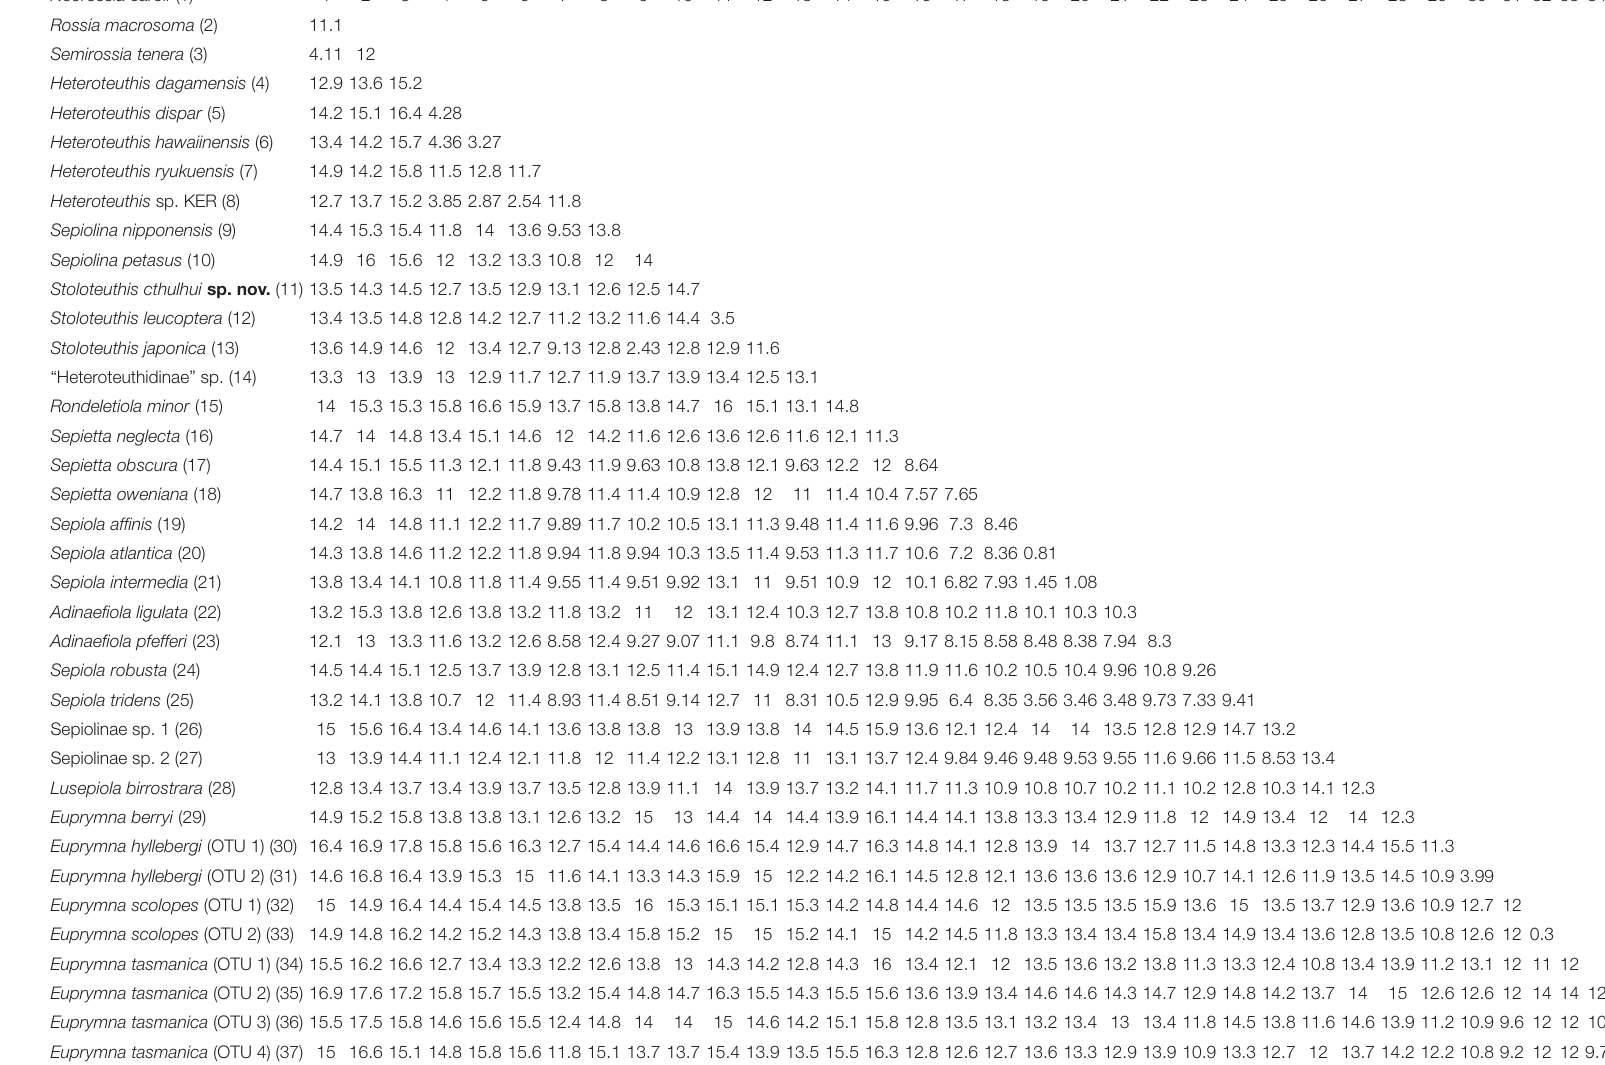
TABLE 2 | Interspecific mean p -distance percenteages (%) between sepiolid taxa. Neorossia caroli